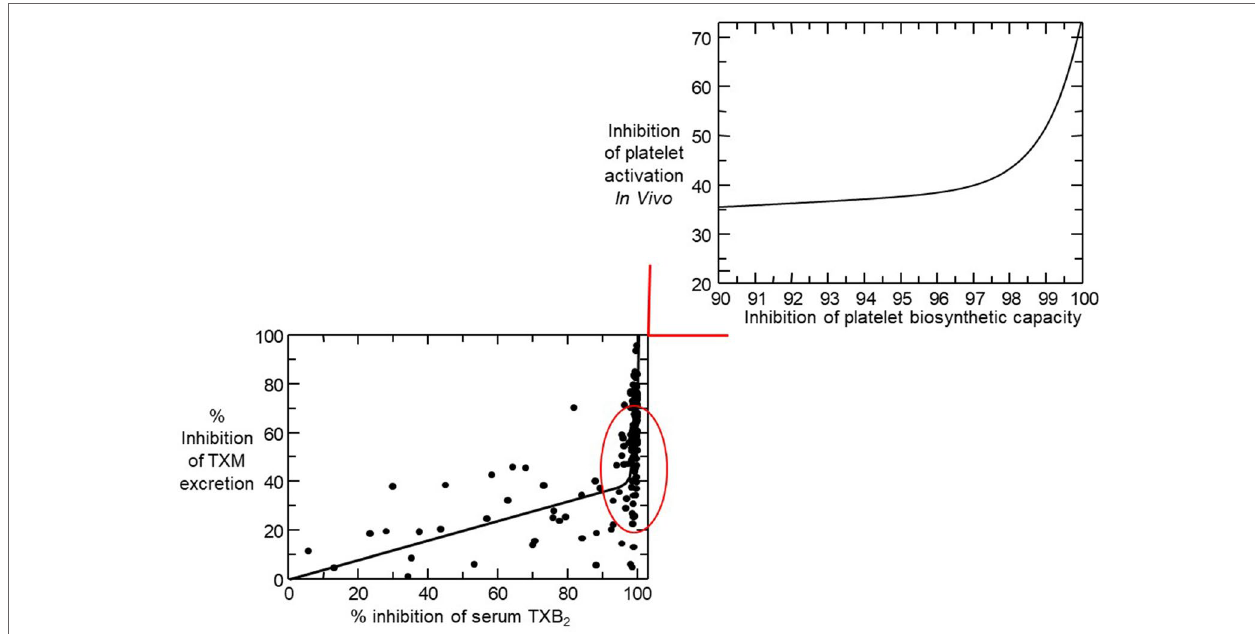
FIGURE 4 | Nonlinear relationship between inhibition of serum thromboxane (TX) B 2 and urinary 11-dehydro-TXB 2 excretion. In the lower left panel, individual percentage inhibition values are depicted from all on-treatment and post-treatment measurements performed in 48 healthy subjects randomized to receive aspirin 100 mg daily for 1 to 8 weeks. The nonlinear relationship between percent inhibition of serum TXB 2 and urinary 11-dehydro-TXB 2 showed that for 0 to 97% of COX-1 inhibition,